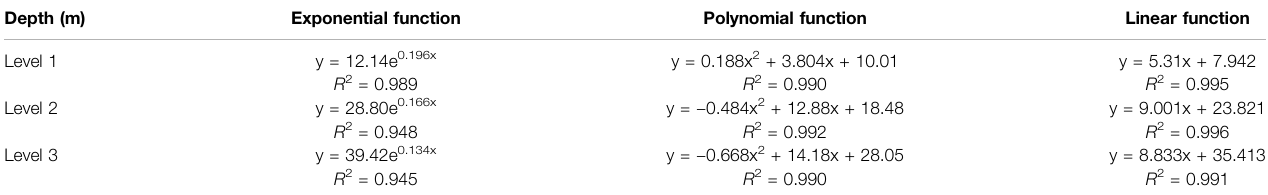
TABLE 1 | Loss functions for rice production. Depth